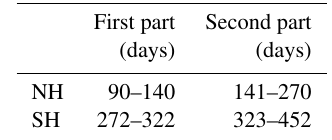
Table 1. Definition of growing season for crops used in Oslo CTM3 in the NH and